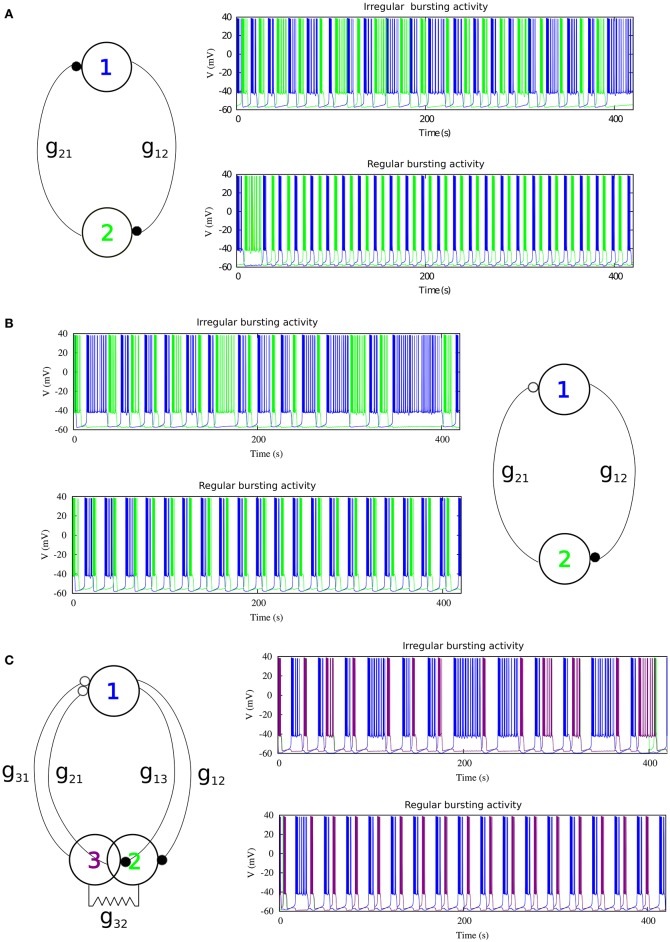
The three different topologies of mutually inhibitory spiking-bursting neural circuits considered in this study. The activity can be irregular or regular depending on the maximal conductances of the synapses and the rest of parameters that control the asymmetry level in each circuit. (A) mutually inhibitory oscillator circuit with temporal symmetric synapses. Black filled circles represent fast graded chemical synapses, see Equation (17). Parameters: Top panel g21 = 0.005 μS, g12 = 0.044 μS (irregular rhythm); Bottom panel g21 = 0.022 μS, g12 = 0.024 μS (regular rhythm). (B) Mutually inhibitory oscillator circuit with temporal asymmetric synapses. The empty circle represents a slow chemical synapse, see Equations (18–19). Parameters: k1 = 0.6 ms−1, k2 = 0.27 ms−1, Top panel g21 = 0.0155 μS, g12 = 0.0255 μS; Bottom panel g21 = 0.0235 μS, g12 = 0.0055 μS. (C) Asymmetric topology with gap-junctions modeled with Eq. (20). Parameters: k1 = 0.6 ms−1, k2 = 0.27 ms−1, Top panel g21, 31 = 0.05 μS, g12, 13 = 0.03 μS; Bottom panel g21, 31 = 0.035 μS, g12, 13 = 0.055 μS.